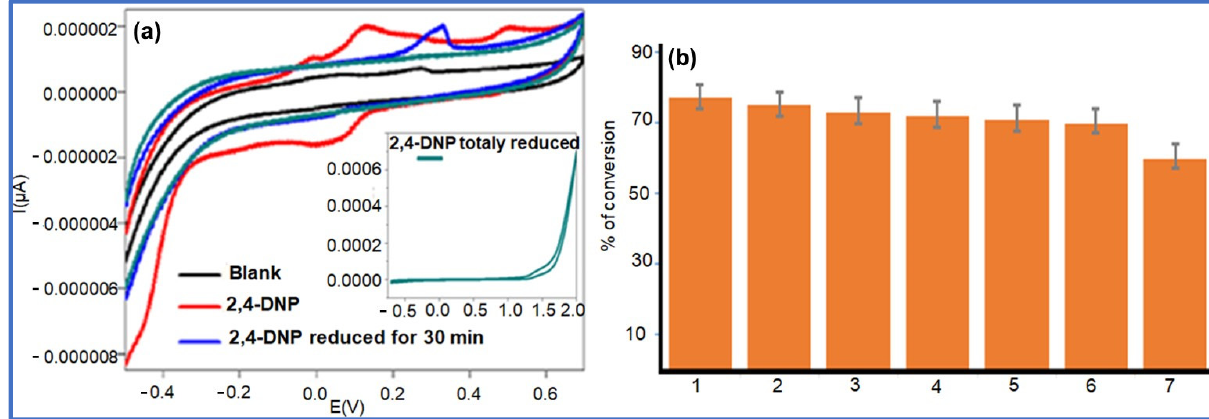
Figure 9. ( a ) Cyclic voltammetry curves obtained with solutions of 2,4-DNP before and after treatment with Ag NPs@GO- FL-CS; ( b ) Reusability test.